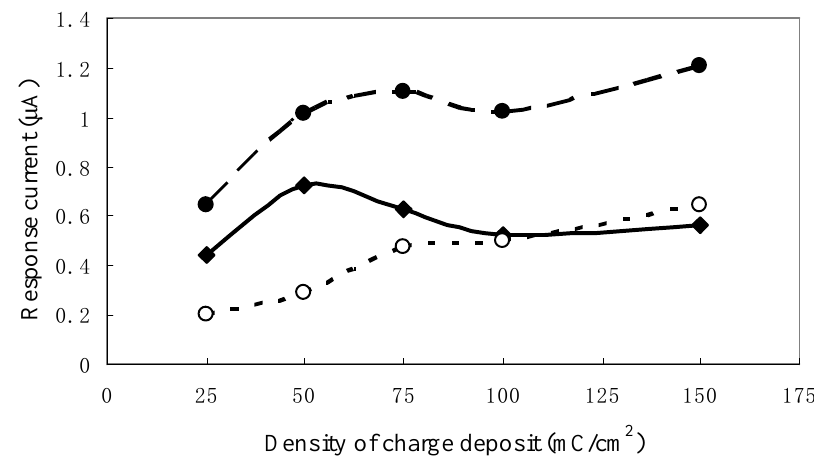
Figure 3. Effect of the density of charge deposit on (a) observed current; (b) background current and (c) response current to 1 H